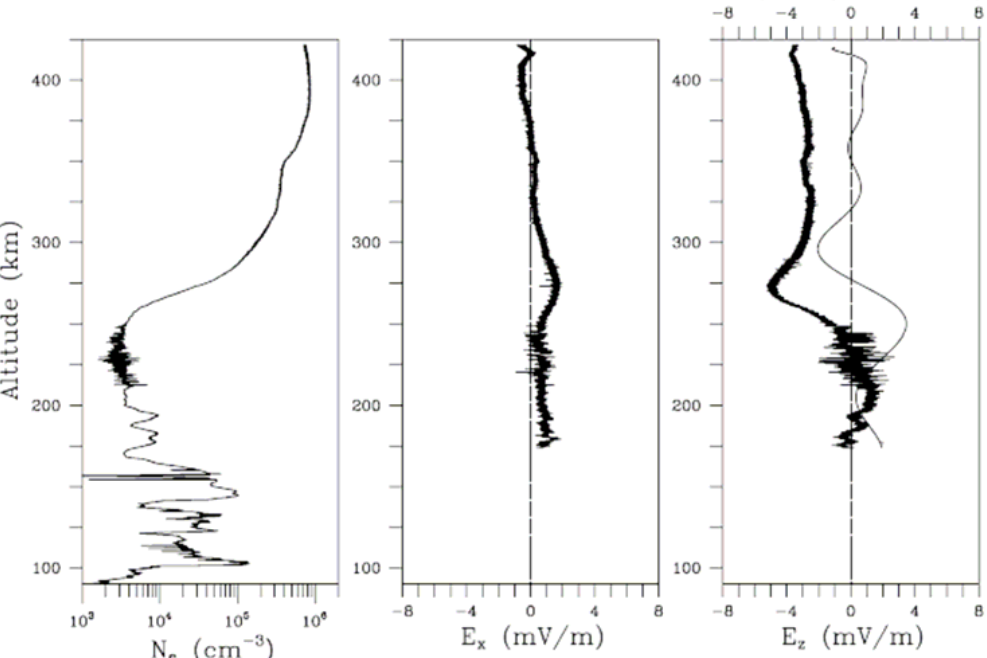
Fig. 15. Rocket measurements of electron density and electric field coincident with the radar scan of Fig. 13. Notice the location of the bottom-type irregularities coincident with the altitudes having a westward drift. Notice also the anisotropic electric fields (and drifts) (after Hysell et al., 2005b).